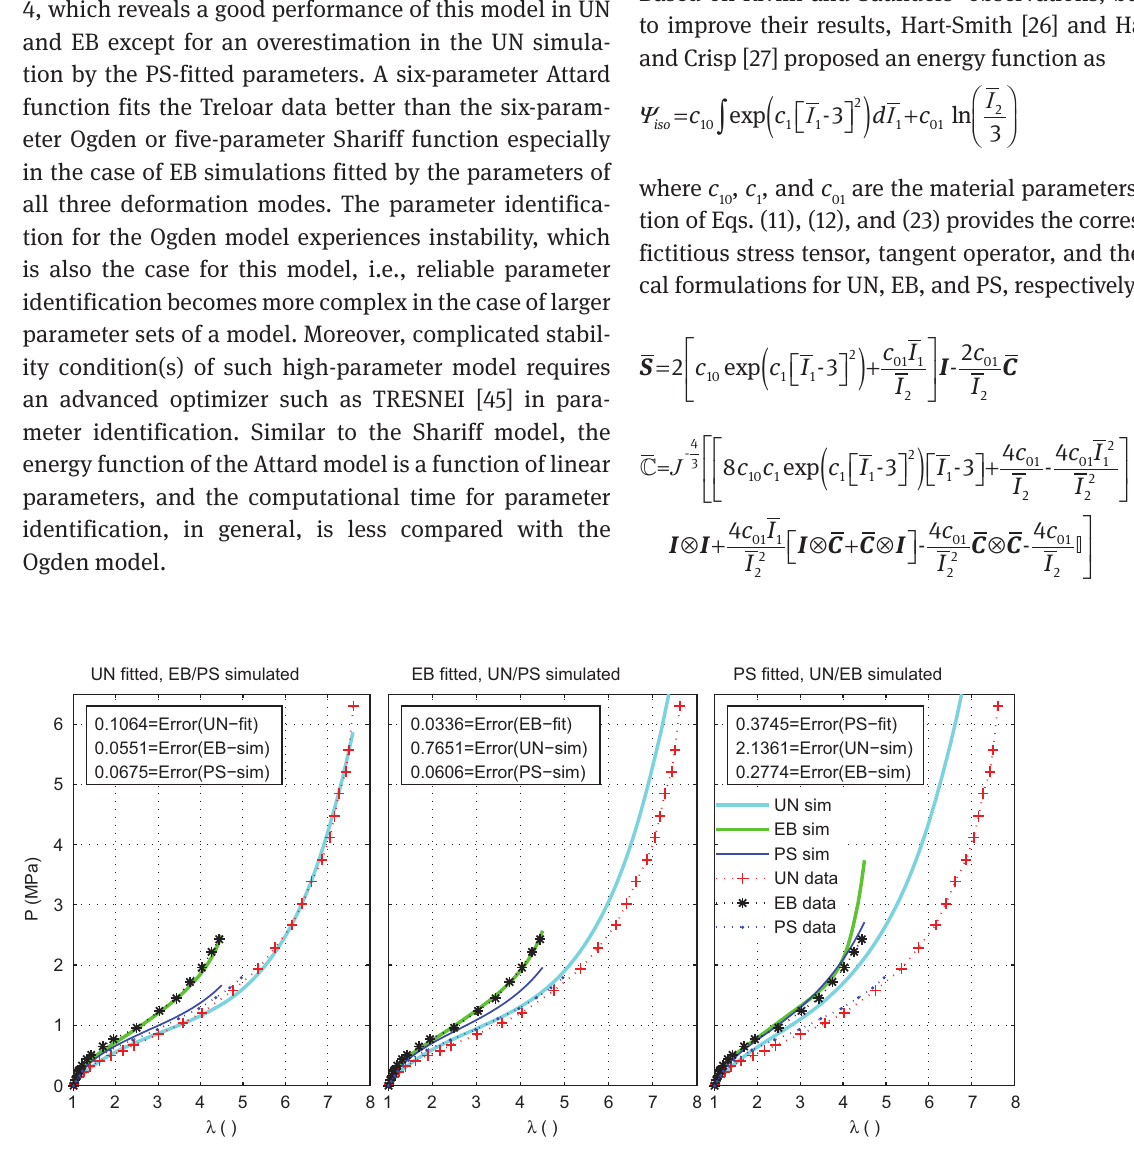
Figure 4 Performance of the Attard model on the Treloar